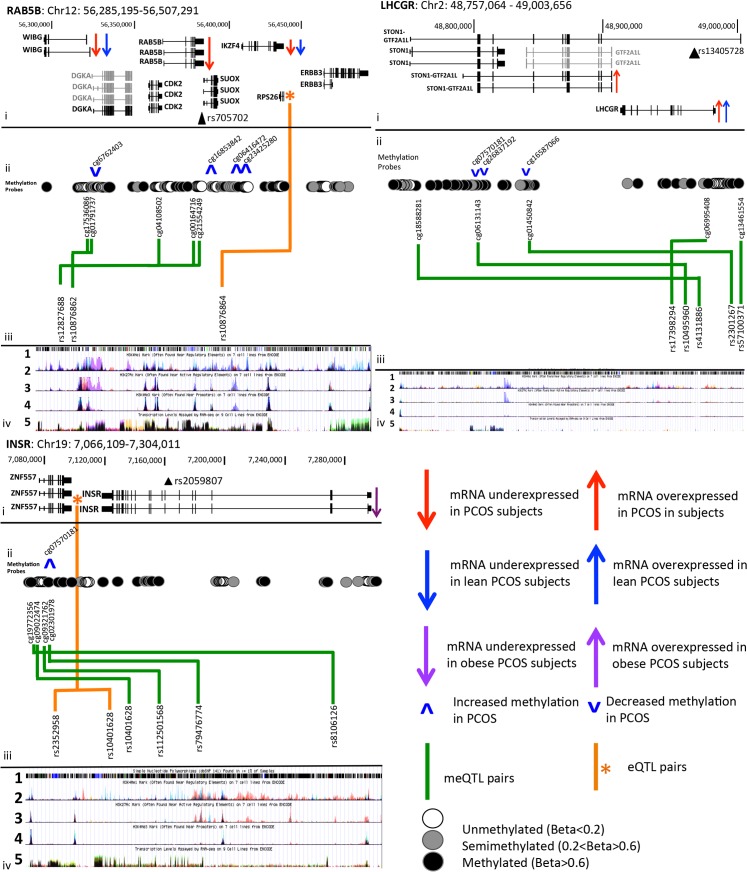
PCOS risk loci contain alterations in gene regulation and expression in PCOS adipose tissue.
i. Chromosomal co-ordinates, gene structure and gene expression profile (grey = not expressed in adipose, black = expressed in adipose). The index PCOS GWAS risk SNP is marked by a filled black triangle and is labeled with rs number. ii. Methylation sites are shown as open (unmethylated), grey filled (semi-methylated) or black (fully methylated) circles, and meQTL relationships between these sites and local SNPs are shown with a green arrow. eQTL results are shown by an orange star marking the gene and orange arrows marking SNP position of independent signals. iii. UCSC Genome Browser ENCODE tracks show 1 SNP position from dbSNP143, 2 poised enhancer activity, 3 active enhancer activity, 4 active promoter activity and 5 transcriptional activity, in 7 Encode reference cell types. iv. meQTL results are shown with box and whisker plots demonstrating mean methylation (Beta level) in each genotype group.